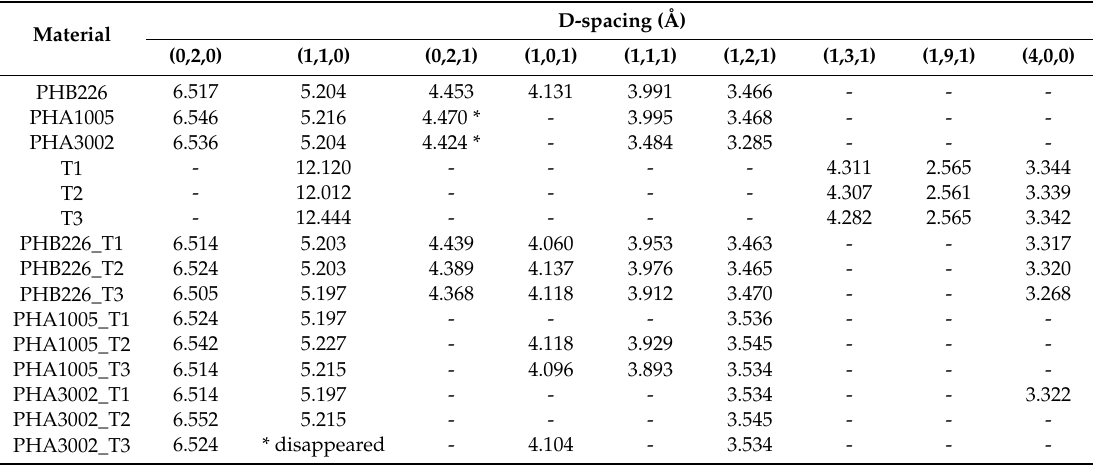
Table 3. Main crystallographic planes and d-spacing calculated from X-ray di ff